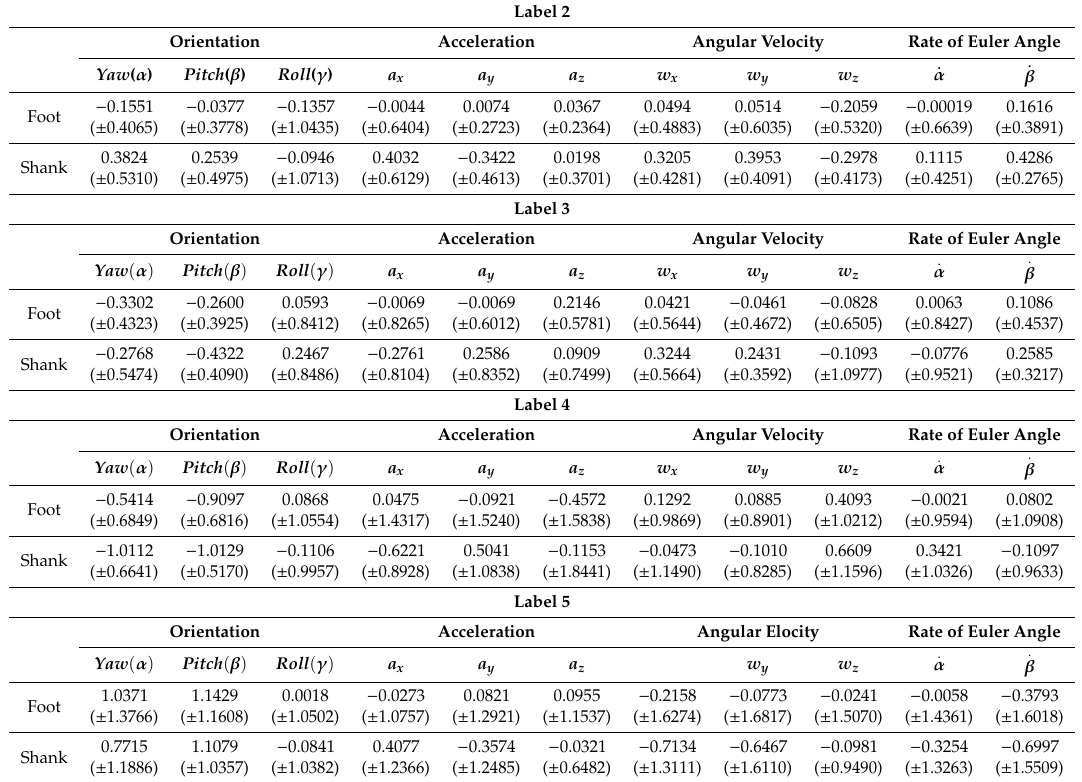
Table A1. Means, standard deviations of every feature of each